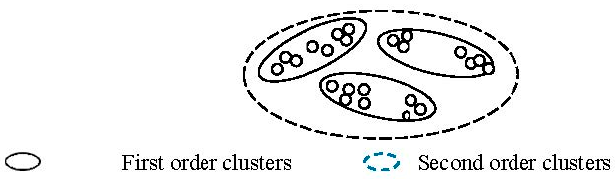
Figure 2. First and second order of cluster distribution.